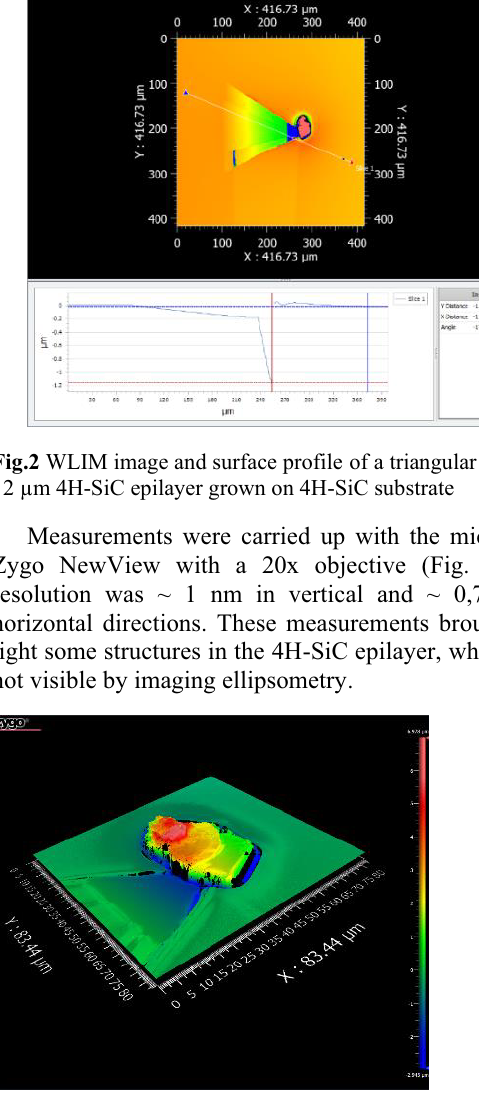
Fig. 3 WLIM 3D-image of the spherical area of defect on 12 μm 4H-SiC epilayer grown on 4H-SiC